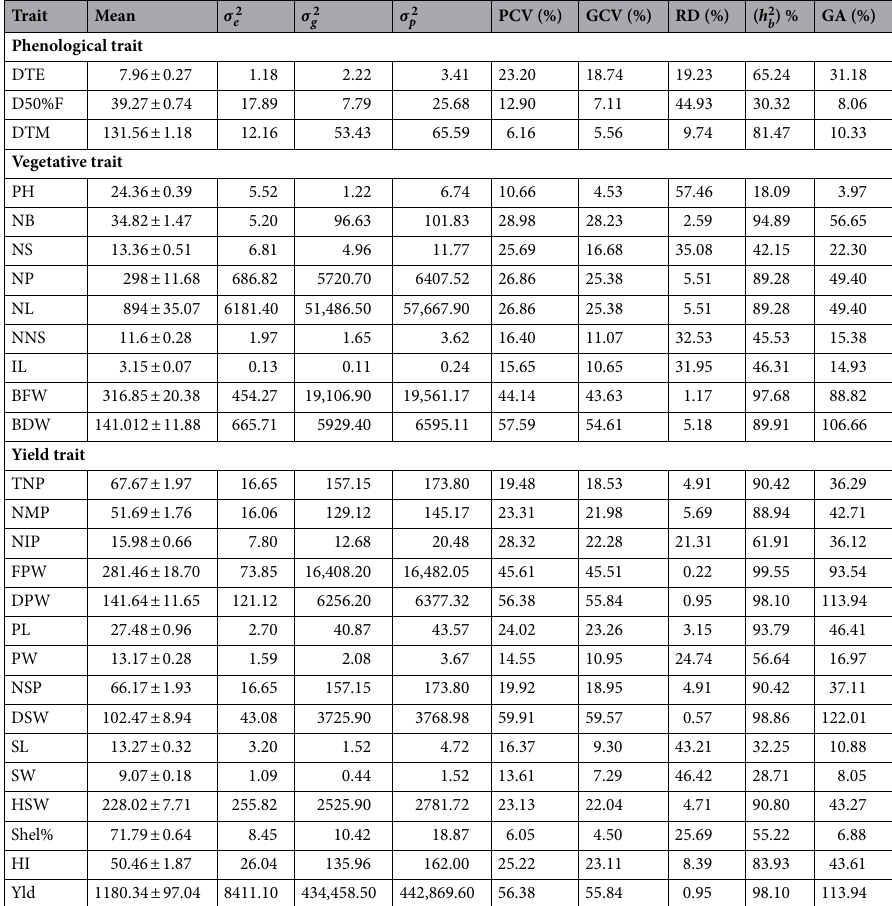
2 Table 7. Variance components, relative difference, heritability and genetic advance of 27 quantitative traits. σ e 2 σ 2 h 2 error variance, σ p phenotypic variance, g genotypic variance, b heritability in broad sense, PCV phenotypic coefficient of variation, GCV genotypic coefficient of variation, RD relative difference, GA genetic advance, DTE (day) days to emergence, D50%F (day) days to 50% flowering, DTM (day) days to maturity, PH (cm) plant height, NB number of branches per plant, NS number of stems per plant, NP number of petioles per plant, NL number of leaves per plant, NNS no. of nodes per stem, IL (cm) inter nodes length, BFW(g) biomass fresh weight per plant, BDW(g) biomass dry weight per plant, TNP total no. of pods per plant, NMP number of mature pods per plant, NIP number of immature pods per plant, FPW(g) fresh pods weight, DPW(g) dry pods weight, PL(mm) pod length, PW (mm) PW, NSP number of seeds per plant, DSW(g) dry seed weight per plant, SL(mm) seed length, SW (mm) seed width, HSW(g) hundred seed weight, Shel% shelling percent , HI (%) harvest index, Yld yield (kg ha −1